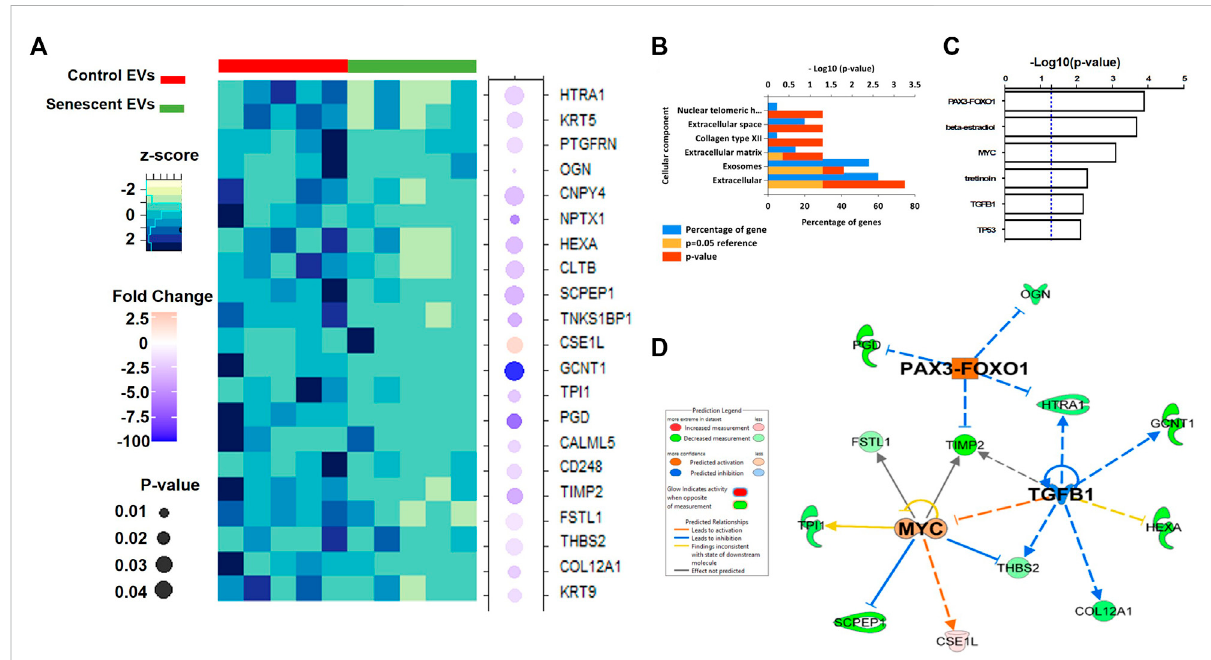
Differentially abundant proteins identi fi ed in senescent EVs. (A) Heatmap of differentially abundant protein contents in EVs (See Table 3). (B) Functional enrichment analysis of proteomics data. (C) Enriched upstream regulators from IPA analysis. (D) Network analysis of identi fi ed upstream regulators and their predicted relationship with EV proteomics